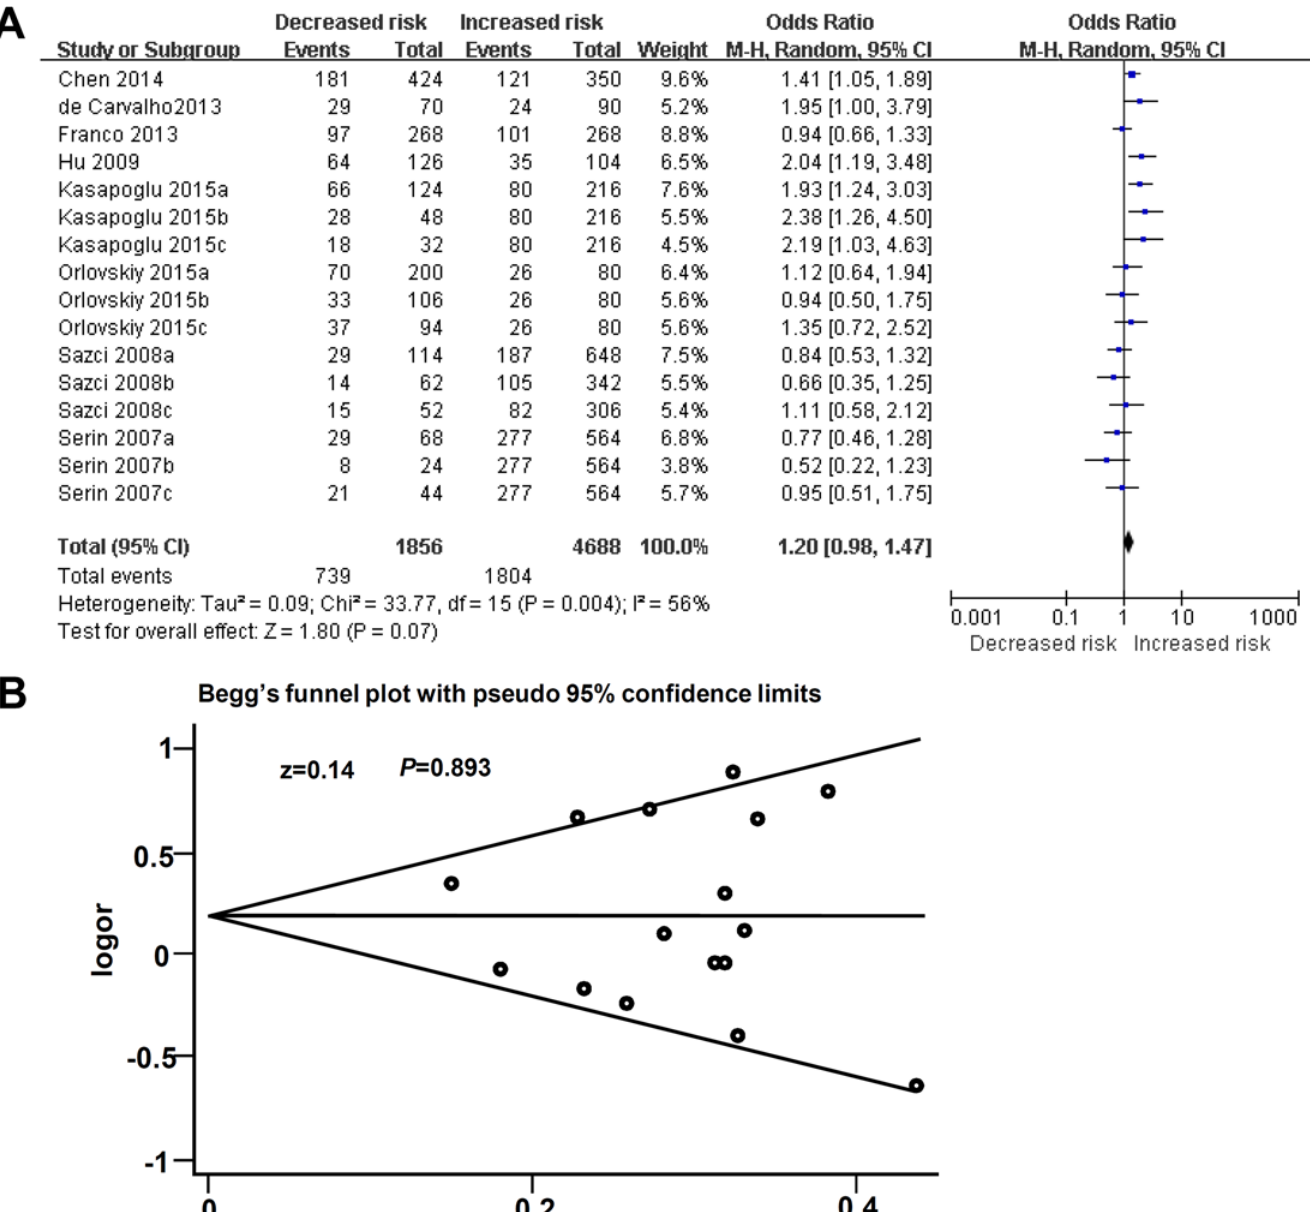
Fig 2. Meta analysis for the association between C677T allele frequency of MTHFR and the risks of NAFLD. (A) Forest plot under T vs C model; (B) Begg ’ s funnel plot of publication biases under T vs C model.